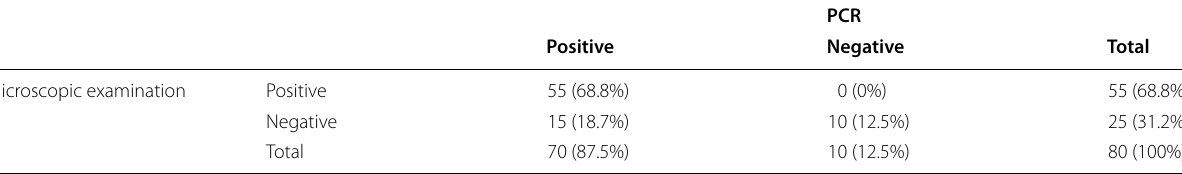
Table 2 Diagnostic performance of microscopic examination and PCR assay for detection of urine schistosomiasis